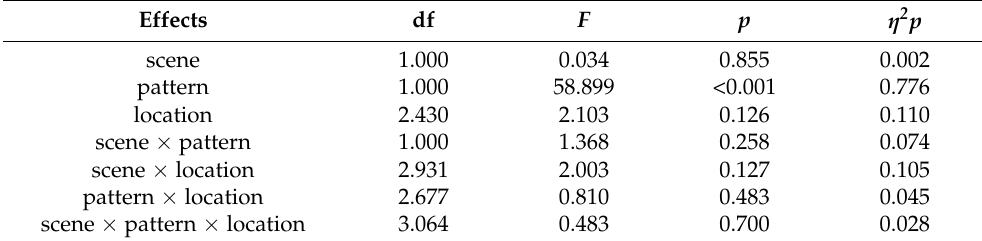
Table 1. The main effect of three-way rmANOVA in the early component.